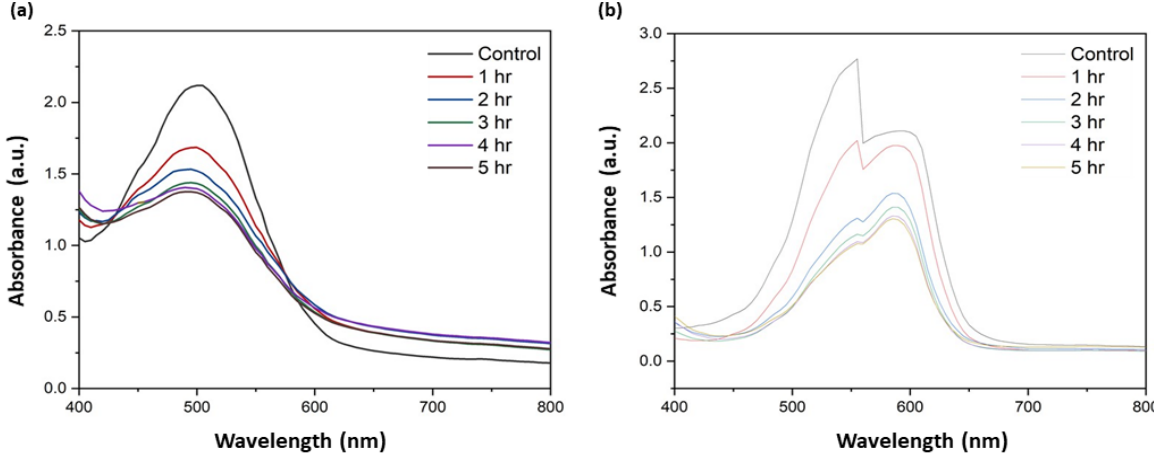
Figure 3. Photodegradation of both ( a ) congo red (CR) and ( b ) crystal violet (CV) dyes treated with Fe 3 O 4 /PVA/eggshell hybrid nanocomposite under sunlight